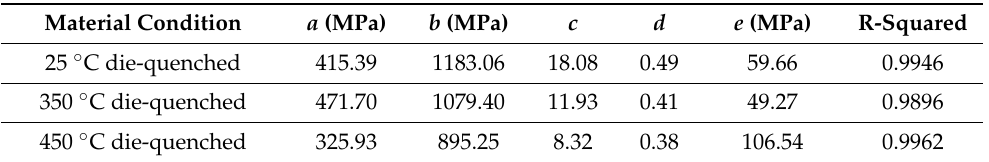
Table A3. The calibrated material parameters of the modified Hockett-Sherby model for various die-quenched conditions of Ductibor ® 1000-AS.